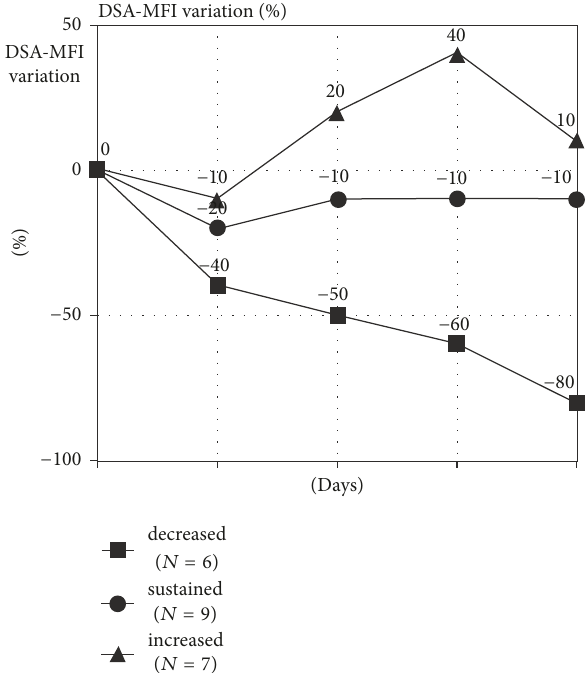
Figure 1: DSA-MFI percentage variation in DSA positive patients over the 1st